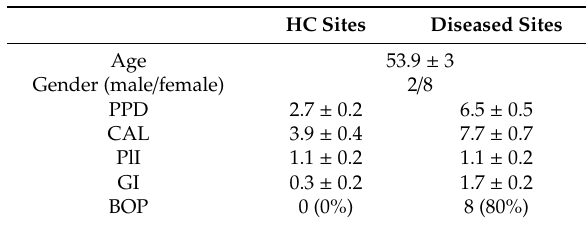
Table 1. Patient characteristics.